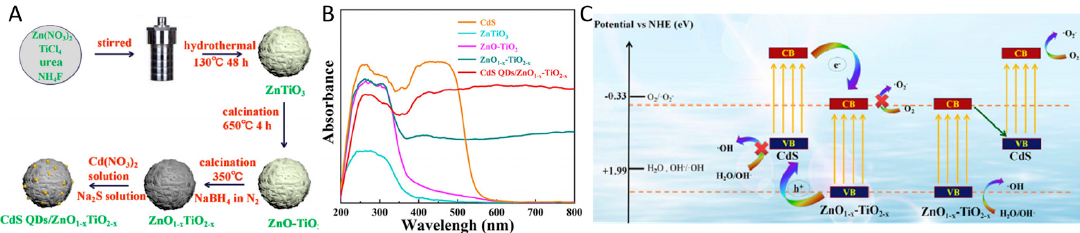
Figure 14. ( A ) Formation process of CdS QDs/ZnO 1 − x -TiO 2 − x ; ( B ) UV-vis spectra; (C) Proposed band alignment and charge transfer mechanism. Reprinted with permission for ref. [120]. Copyright 2020, Elsevier.